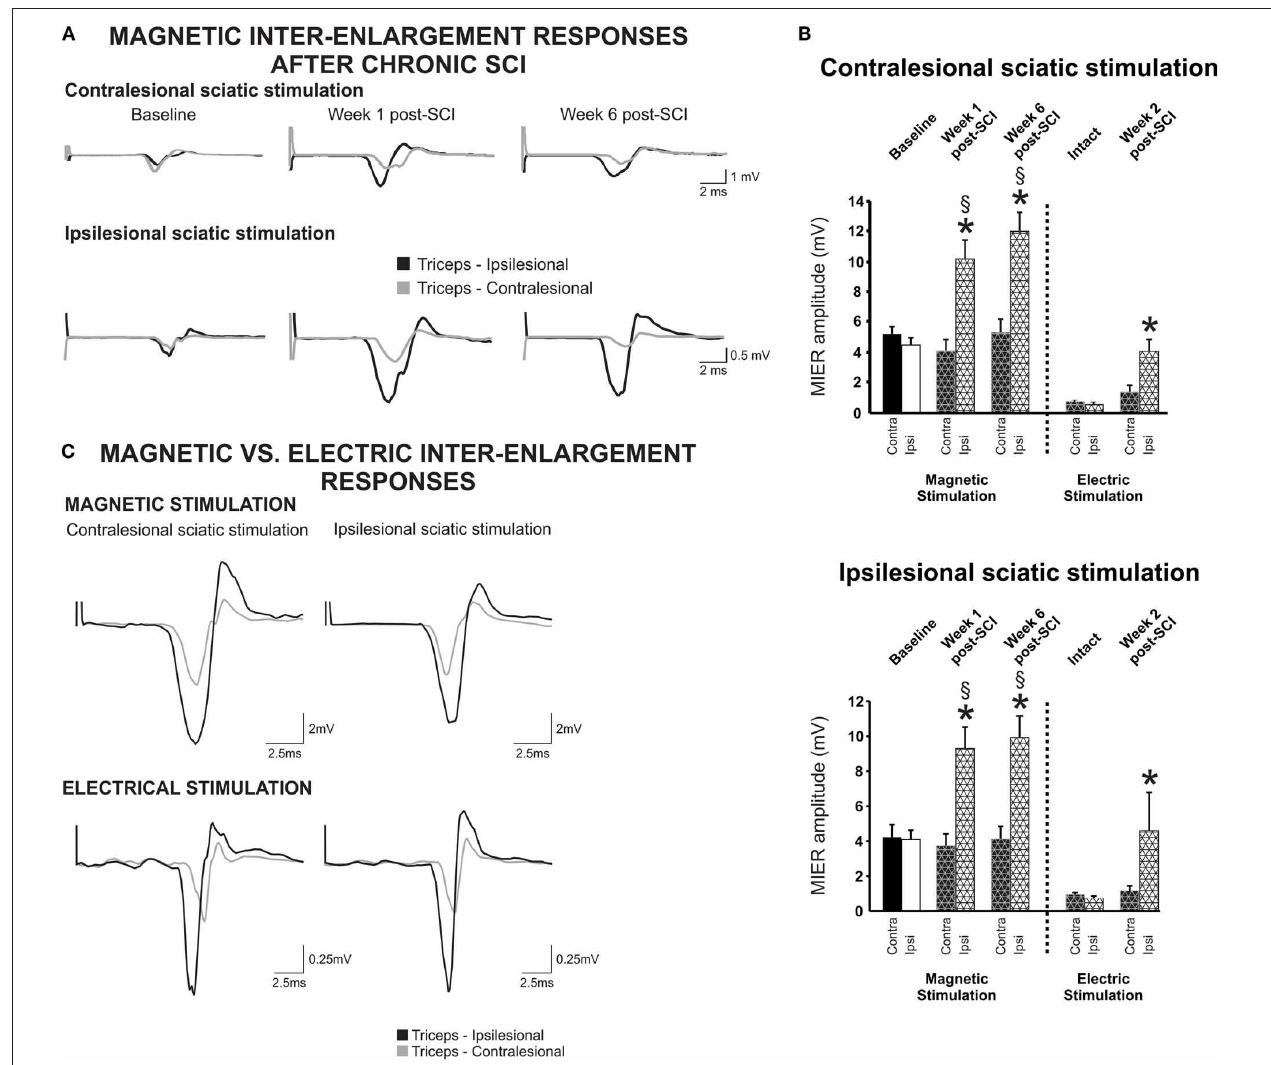
FIGURE 3 | Inter-enlargement responses are enhanced on the ipsilateral side of the lesion after a cervical hemicontusion injury. (A) Inter-enlargementresponses are recorded in the ipsilesional and contralesional triceps muscles following magnetic stimulation of the ipsilesional or contralesional sciatic. Representative traces recorded from a single animal illustrate that the response in the ipsilesional triceps (black) is larger than in the contralesional triceps (gray) after SCI. The MIER is also delayed, i.e., the latency in the contralesional triceps is significantly longer than in the ispilesional side whether the stimulation is evoked from the ispilesional or contralesional sciatic. (B) Regardless of ipsi- or contralesional